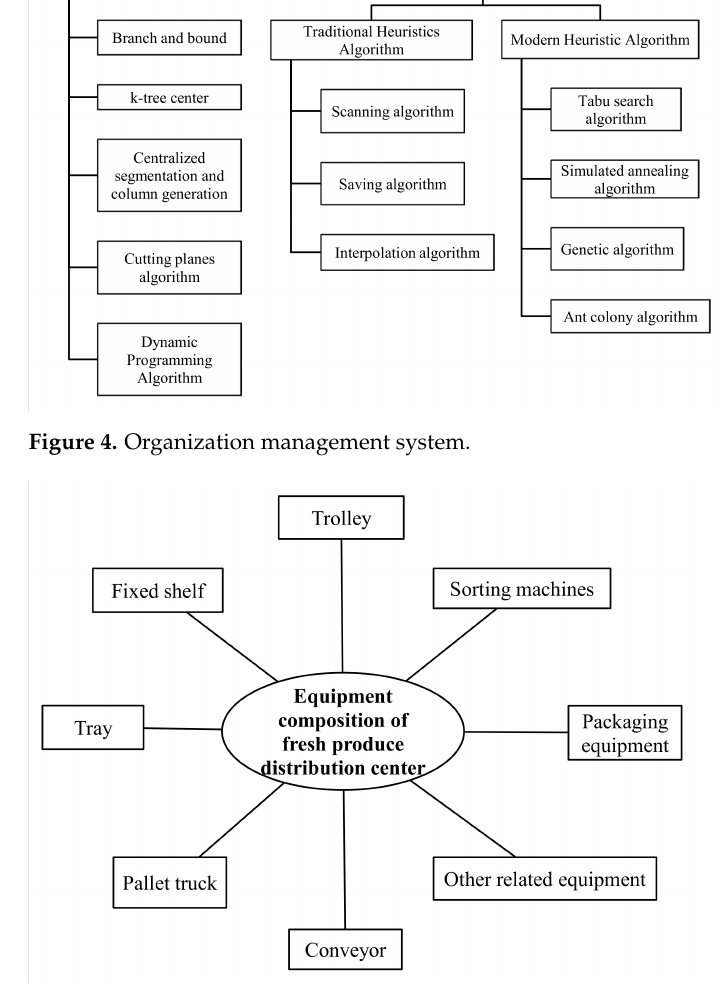
Figure 5. Equipment composition